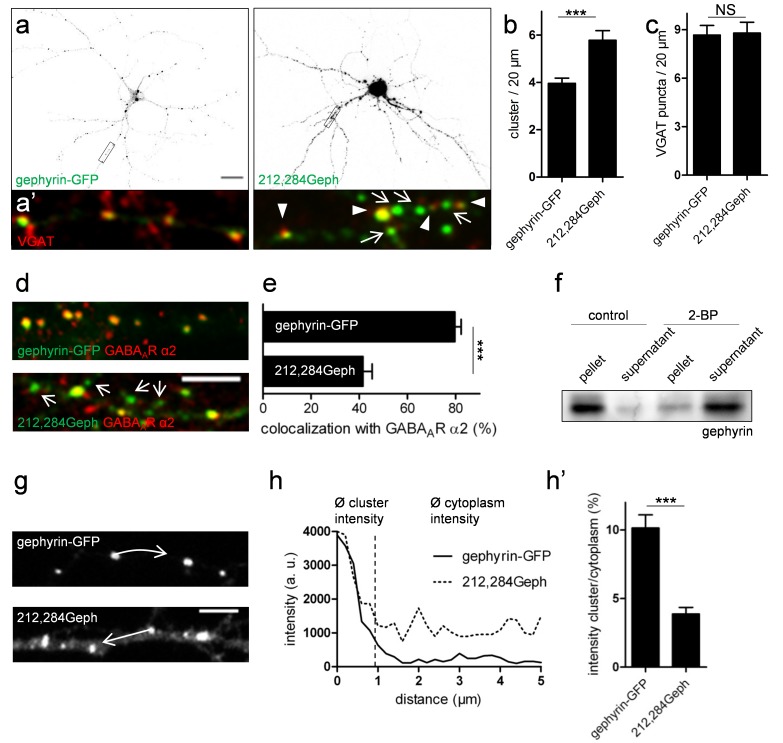
Morphological analysis of palmitoylation-deficient gephyrin variants in primary hippocampal neurons.(a) Representative examples are illustrated for WT gephyrin-GFP and 212,284Geph. Scale bar, 20 µm. (a′) Insets demonstrate postsynaptic clustering of gephyrin by colocalization with VGAT (red). 212,284Geph clusters show postsynaptic (arrowheads) and nonsynaptic (arrows) localization. (b, c) Quantitative analysis of (b) gephyrin cluster numbers and (c) VGAT puncta in gephyrin-GFP and 212,284Geph-transfected primary hippocampal neurons. (d) Colocalization of gephyrin-GFP and 212,284Geph clusters with GABAAR α2 immunofluorescence. Arrows show 212,284Geph clusters that are not localized at GABAergic synapses. Scale bar, 5 µm. (e) Quantitative analysis of cluster colocalized with α2-containing GABAARs. (f) Representative immunoblot of subcellular fractionation of 14 DIV cultured hippocampal neurons after incubation with 50 µM 2-BP or the solvent. (g–h) Quantitative line-scan analyses of fluorescence intensities ranging from individual clusters towards the cytosol as indicated by white arrows. Scale bar, 5 µm. (h′) Histogram shows quantification of cluster/cytoplasm intensity rations in gephyrin-GFP compared to 212,284Geph-transfected dendrites. All data are means ± SEM (***p<0.001 using Student's t test; NS, not significant). At least three independent cultures were used for the quantifications.